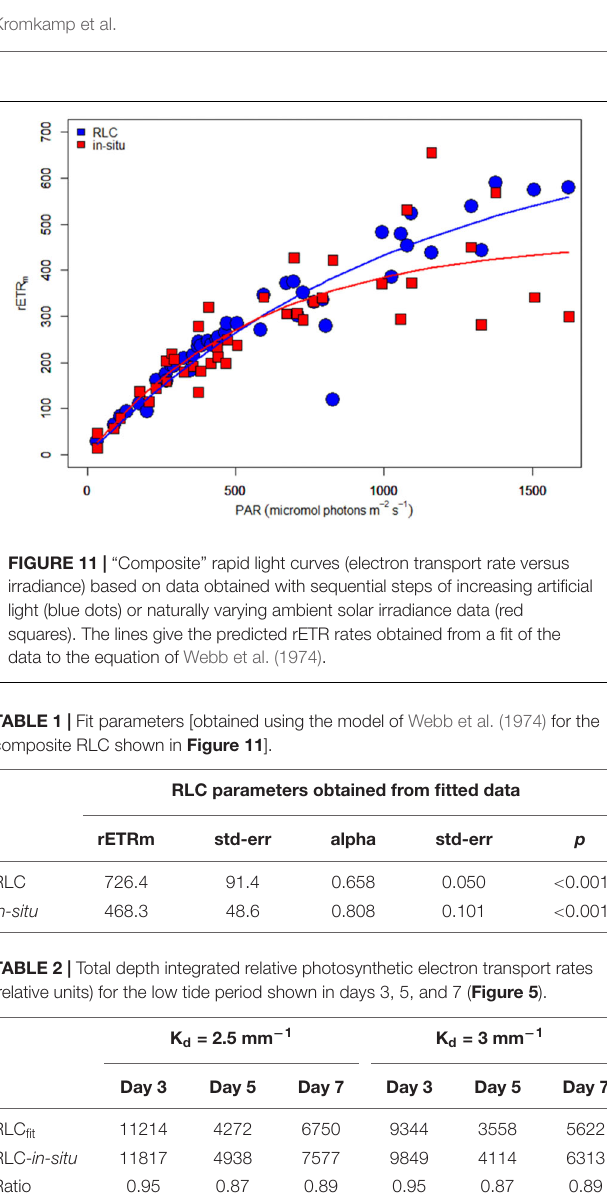
Only the fit parameters and the hourly averaged irradiance data of these days were